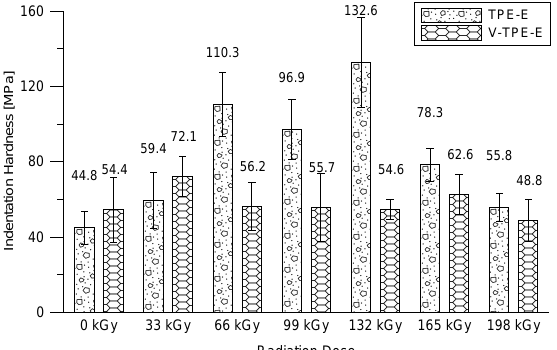
Figure 13. Nano-indentation hardness dependence on the radiation